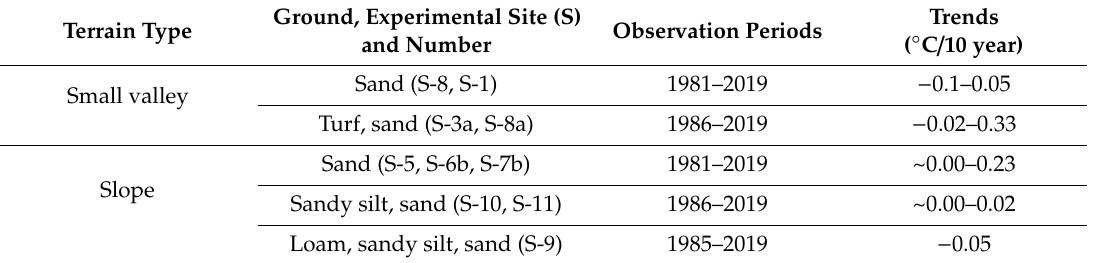
Table 5. Trends in mean annual ground temperature at the depth of zero annual amplitude (10